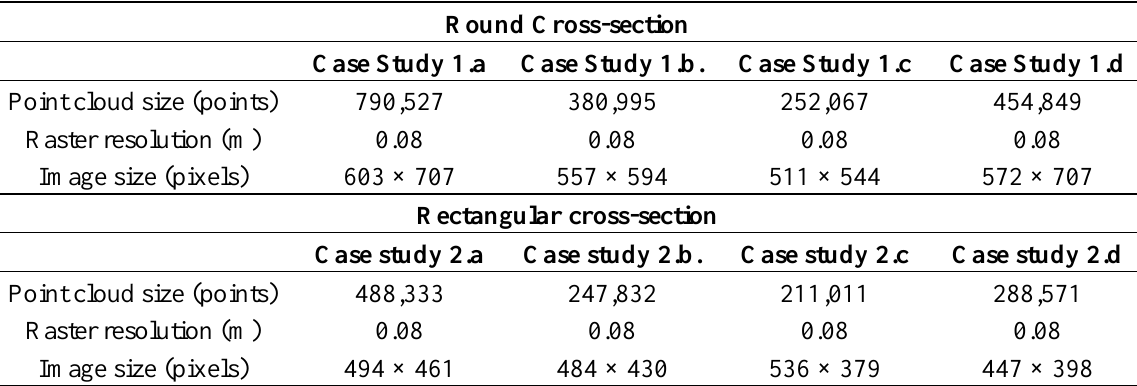
Figure 8. The proposed methodology is tested through four tests depending on the data completeness for the round column case study: complete dataset ( a ), two scan positions placed at different sides of the building ( b ), one isolated scan position ( c ), and two scan positions placed at the same side of the building ( d ). Table 2. The results of the rasterization process.